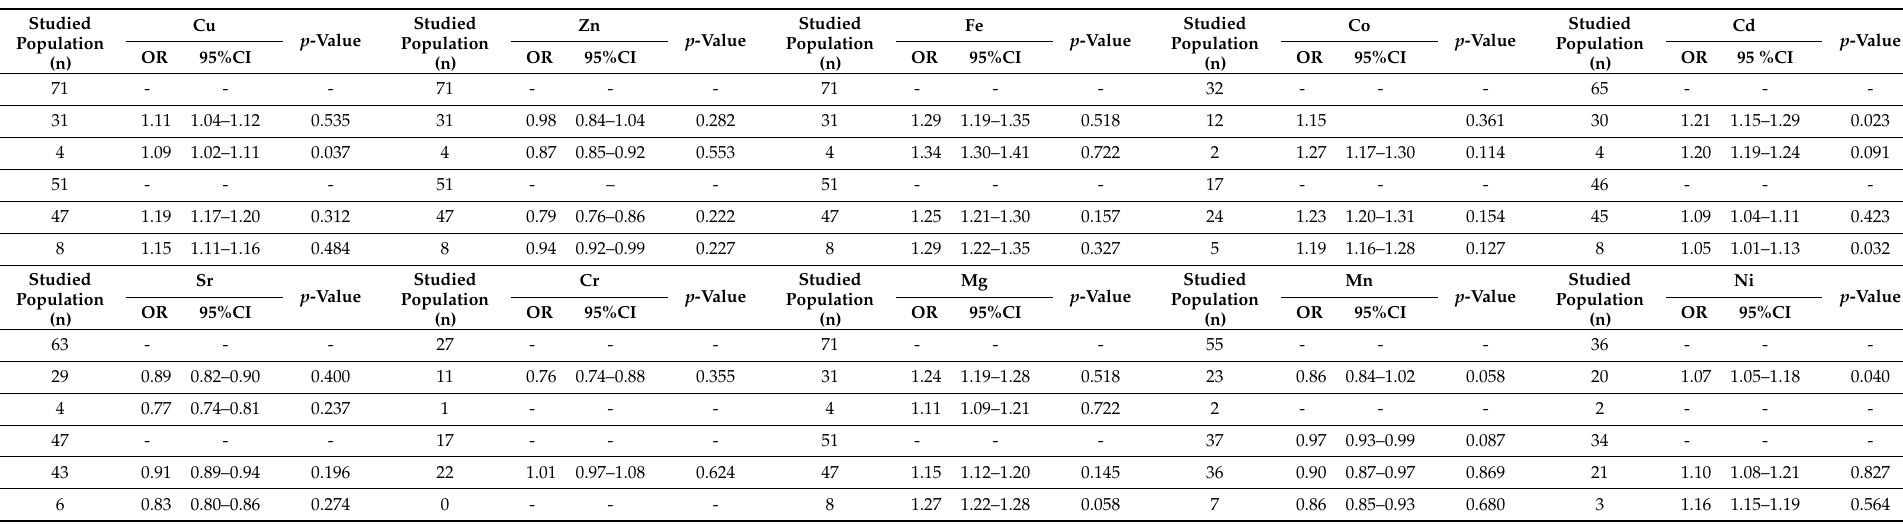
Table 8. Polymorphisms prevalence with regard to metalloestrogen